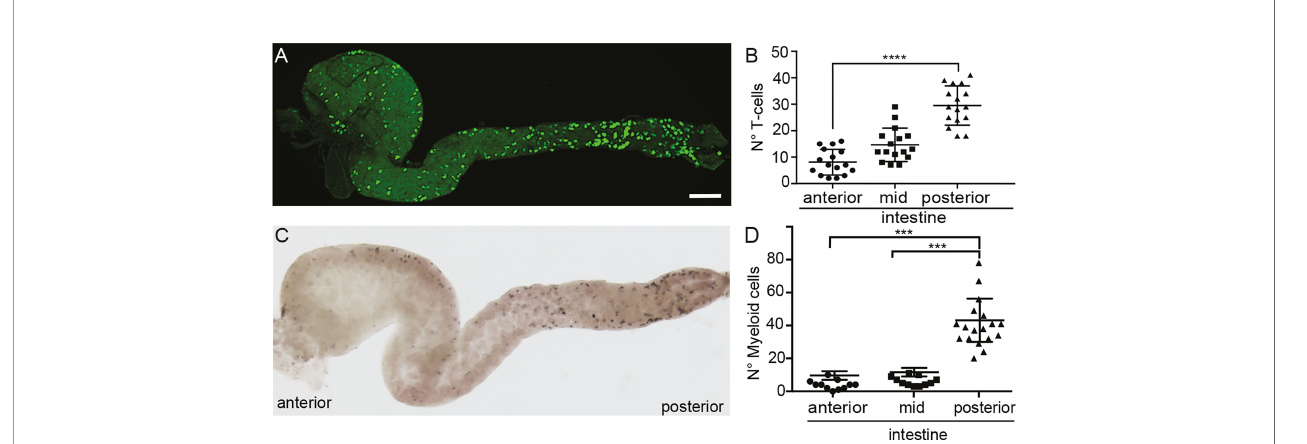
FIGURE 1 | Localization of T cells and myeloid cells in the gut of medaka. (A) Representative image of a dissected intestine, including anterior, mid and posterior segments, of a Tg(lck:GFP) fi sh showing the distribution of GFP+ T cells. (B) Quanti fi cation of the number of GFP+ T cells in the three segments of the intestine. (C) Representative image of a dissected intestine of wild-type larva stained with Sudan-Black revealing the distribution of myeloid cells along the anterior-posterior axis. (D) Quanti fi cation of Sudan-Black+ cells in the anterior, mid and posterior gut. Statistical analysis was performed with Kruskal Wallis test. ***p < 0.001, ****p < 0.0001. Scale bars 100 µm. All assays were performed at least three independent